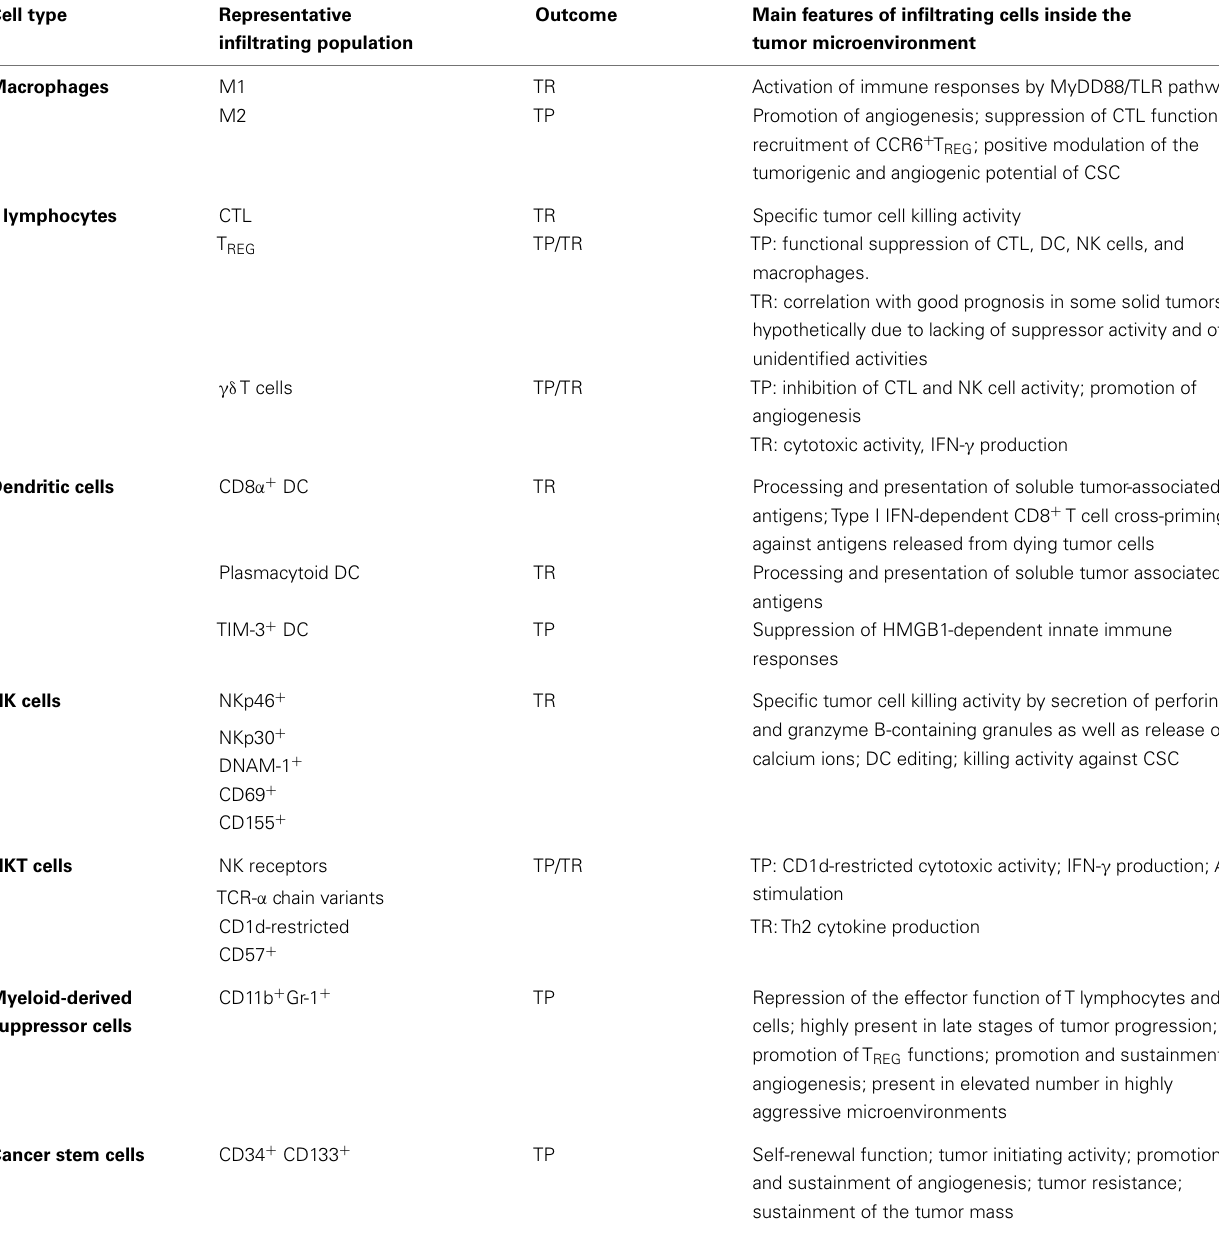
Table 2 | Immune cells infiltrating the tumor microenvironment and their role in tumor progression. Cell